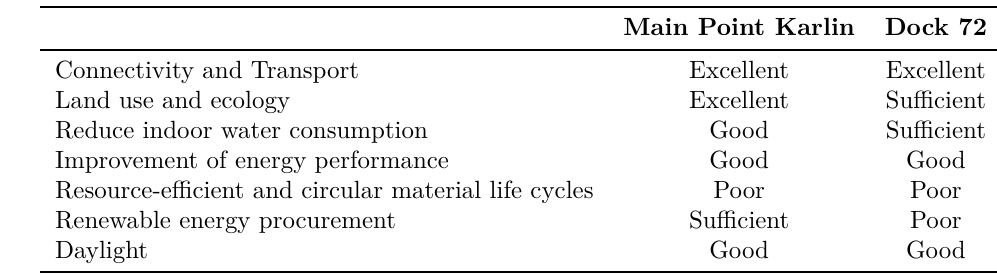
Table 3. Qualitative assessment for sustainability criteria.